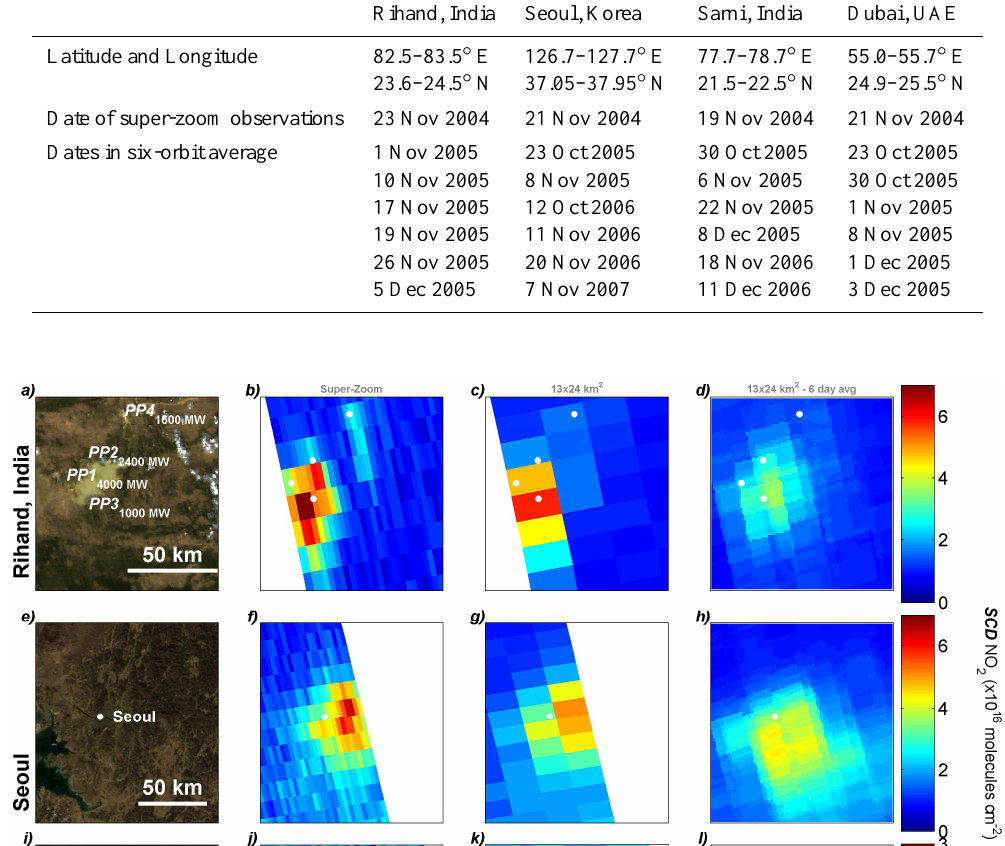
retrieved from OMI super-zoom and operational resolution 3 2